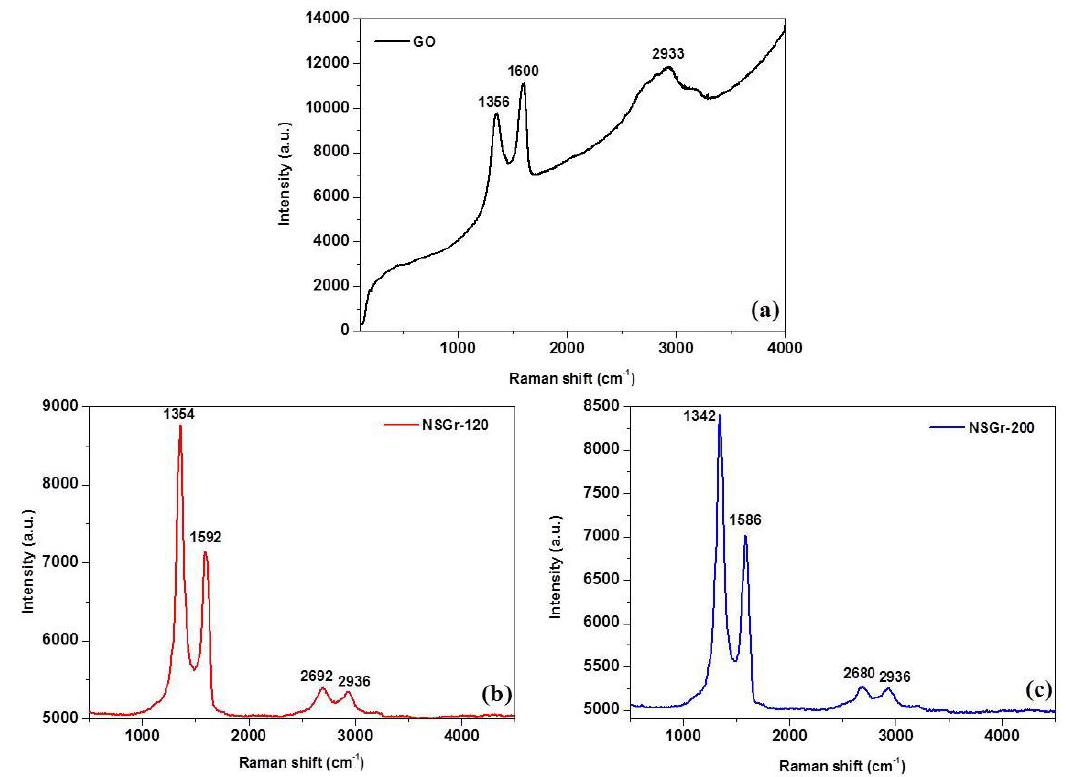
Figure 6. Raman spectrum of GO ( a ) and nitrogen and sulfur co-doped graphene samples: NSGr-120 ( b ); NSGr-200 ( c ) .